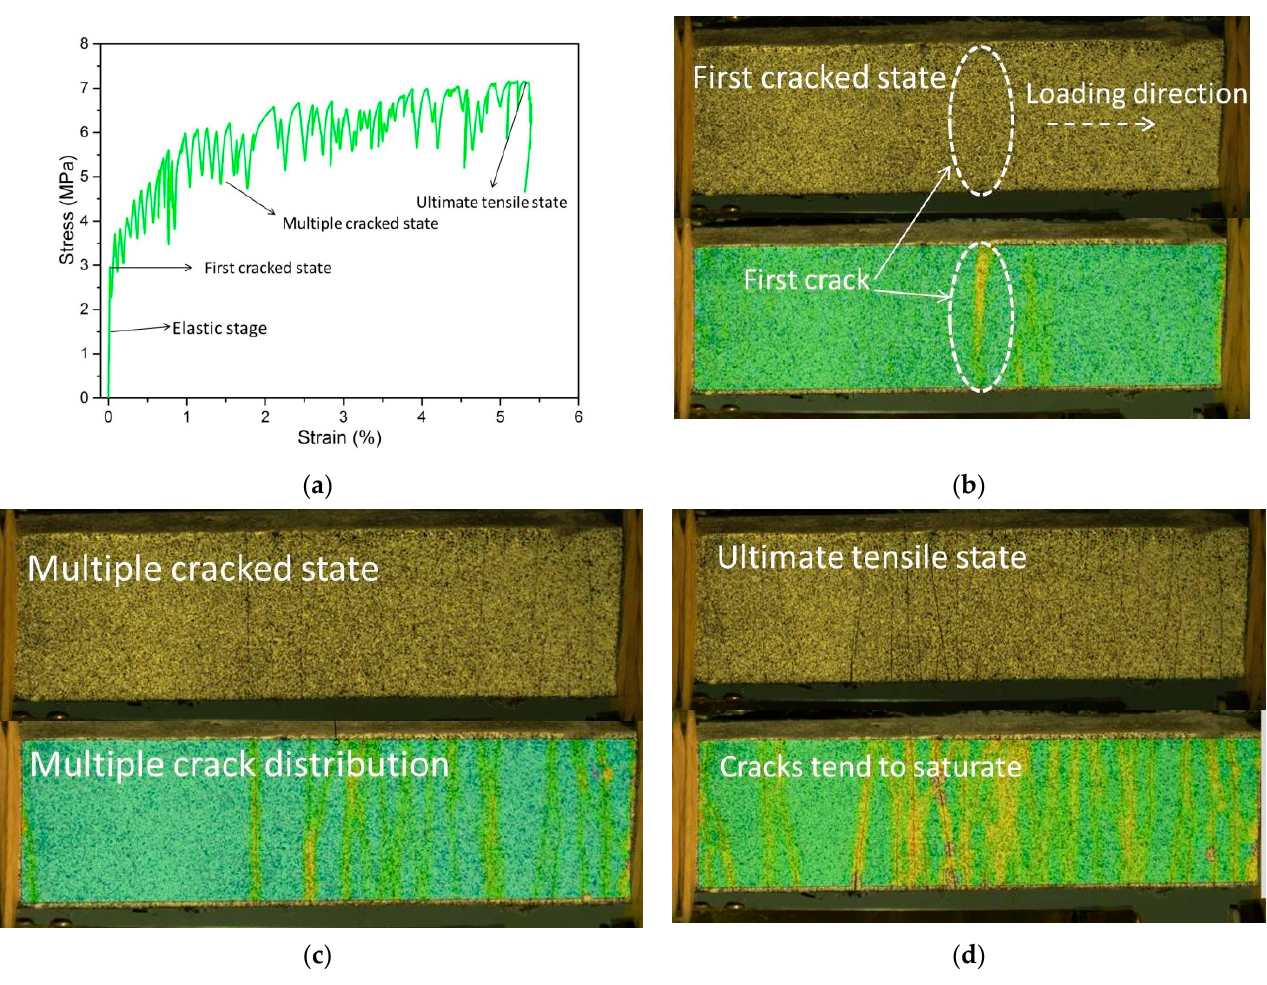
Figure 8. Strain field of GLECCs under different strains. ( a ) Tensile stress–strain curve of FAC0.15 − PE1.5; ( b ) the strain contours of the initial crack state; ( c ) the strain contours of the multiple cracked state; ( d ) the strain contours of the ultimate tensile state.